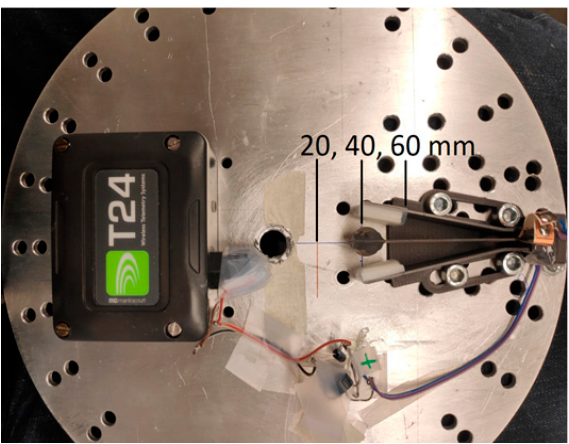
Figure 3. Alignment of piezoelectric cantilever harvester. Tip mass pointing toward center axis.